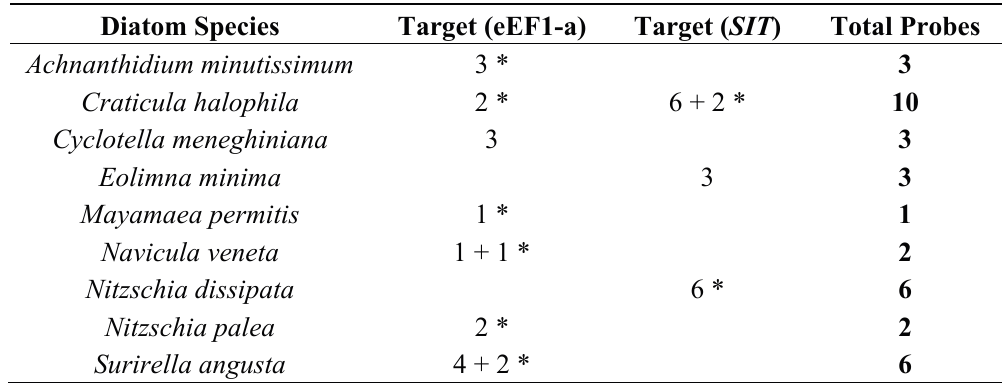
Table 2. Summary of the discriminatory power displayed by oligonucleotide probes targeting two marker genes in microarray hybridization experiments. Diatom Species Target (eEF1-a) Target ( SIT ) Total Probes Achnanthidium minutissimum 3 * 3 Craticula halophila 2 * 6 + 2 * 10 Cyclotella